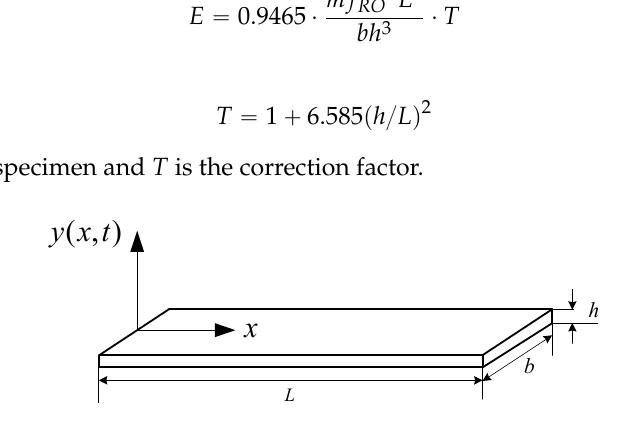
Figure 1. Specimen and its vibrating coordinate system.